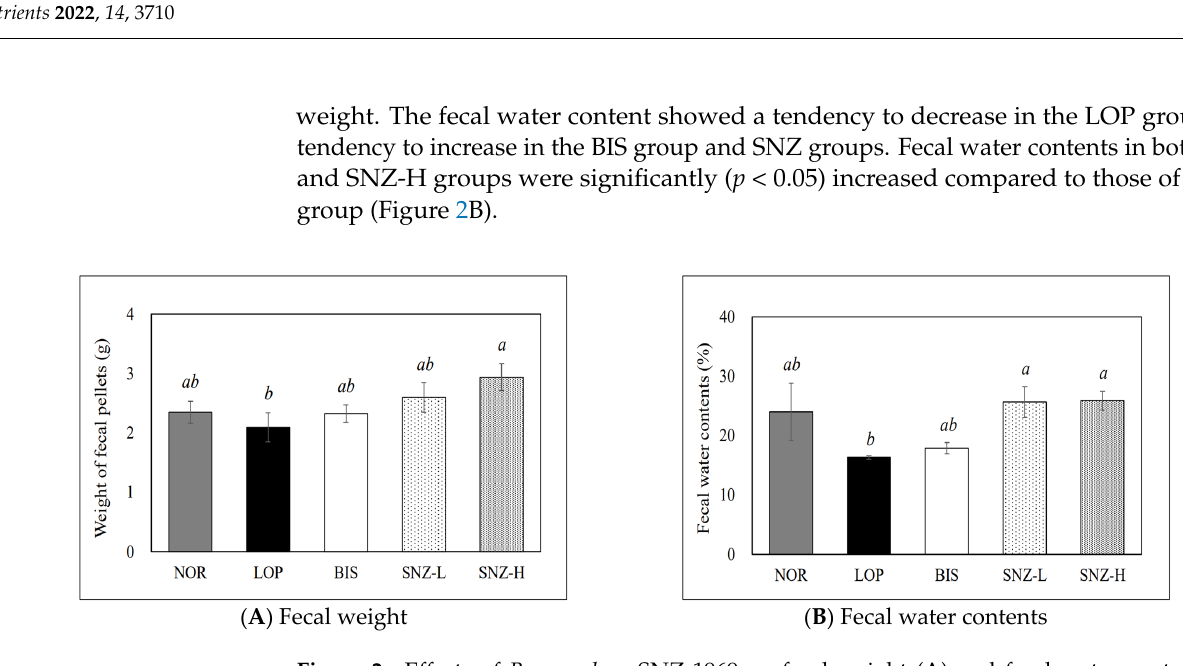
Figure 2. Effects of B. coagulans SNZ 1969 on fecal weight ( A ) and fecal water contents ( B ) in loperamide-induced constipation rats. NOR: Normal group; LOP: Loperamide treated group; BIS: Loperamide and Bisacodyl 8 mg/kg treated group; SNZ-L: Loperamide and B. coagulans SNZ 1969 at 1 × 10 8 CFU/day treated group; SNZ-H: Loperamide and B. coagulans SNZ 1969 at 1 × 10 10 CFU/day treated group. Results are presented as mean ± SE (n = 8). Means with the different letters above a bar are significantly different at p < 0.05 by Duncan’s multiple range test.